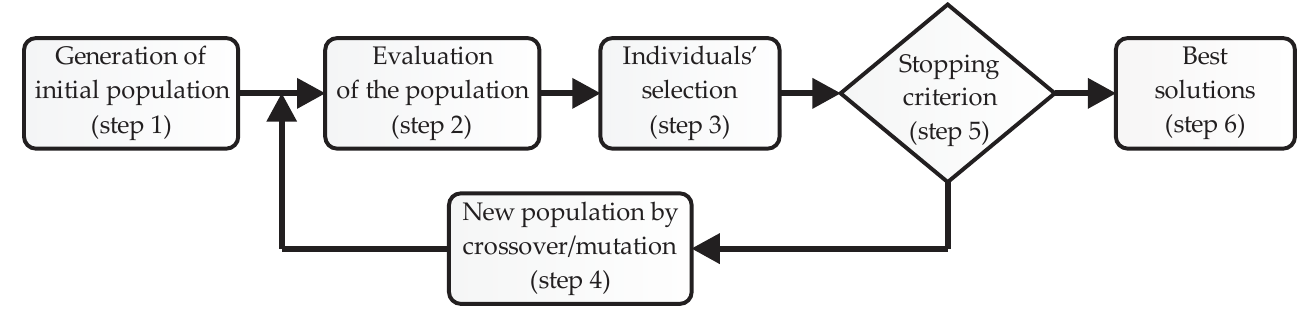
Figure 2. Flow diagram of the steps for implementing the GA.